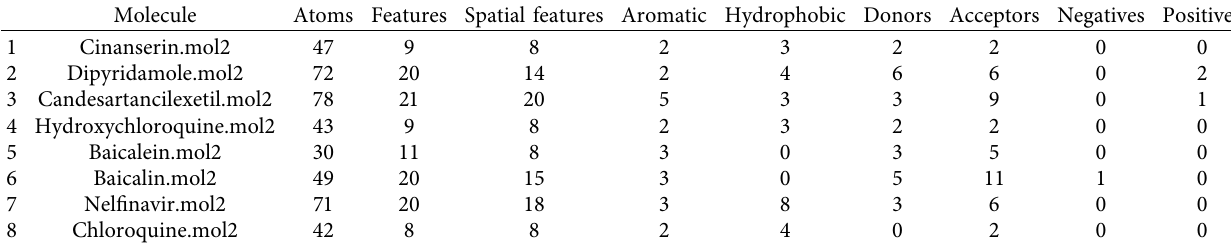
Table 2: Input molecules with their detected features visualized.